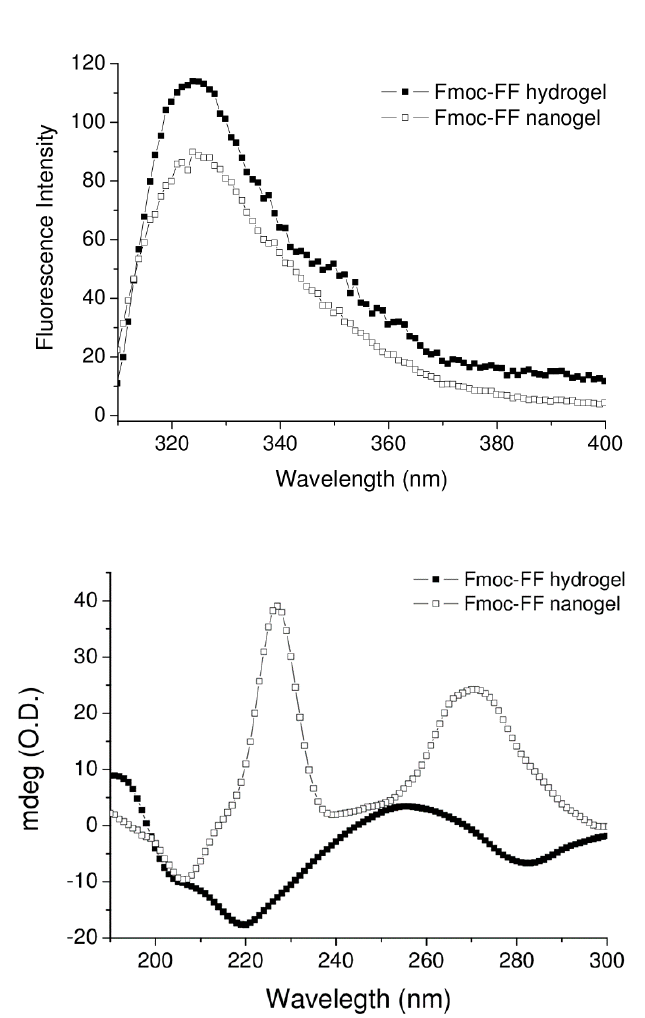
Figure 5. Structural characterization of nanogels prepared by inverse emulsion method. Fluorescence spectrum ( A ) and circular dichroism (CD) spectrum ( B ) of Fmoc-FF nanogel formulation as compared with fluorescence and CD spectra of Fmoc-FF hydrogel.